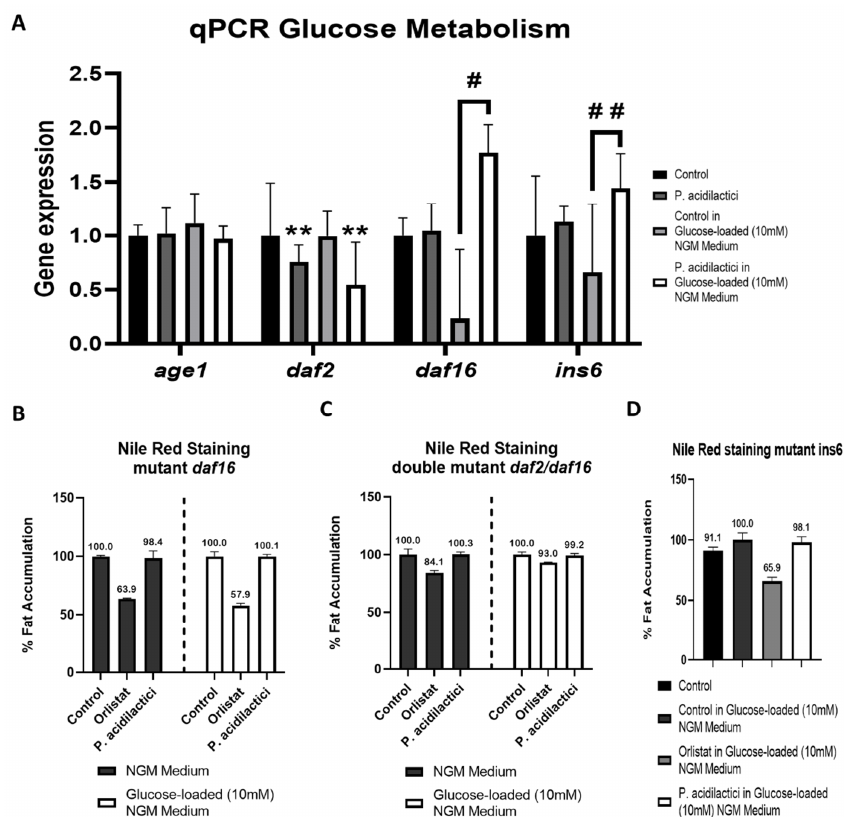
Figure 2. ( A ) Gene expression analysis quantified by real-time PCR (qPCR) in C. elegans . Gene expression levels were normalized to the housekeeping gene ( pmp-3 ). Data are expressed using the 2 −∆∆ Ct method. A two-way ANOVA (main effects: pA1c, glucose and their interaction), followed by a Student´s t-Test was carried out to evaluate statistical differences between groups: Two-way ANOVA results when pA1c factor is significant: ** p < 0.01; Student´s t-Test when interaction be- tween factors is significant: # p < 0.05 vs. control in a glucose-loaded NGM medium, # # p < 0.01 vs. control in a glucose-loaded NGM medium. Nile Red quantification of PA-treated worms in daf-16 mutant ( B ), double mutant daf-2/daf-16 mutant ( C ) and ins-6 mutant ( D ) in a NGM medium and in a glucose-loaded (10mM) NGM medium. Statistical analyses were performed using Student´s t-Test to study differences between groups.